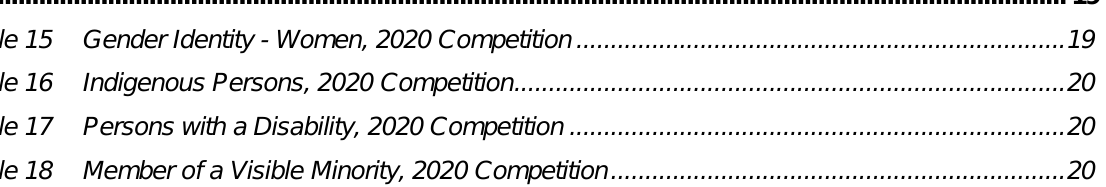
Overall Comparative Statistics, Subatomic Physics Programs Competitions, 2016-20 ....... 19 SECTION 6 - COMPETITION RESULTS DISAGGREGATED BY APPLICANT SELF-IDENTIFICATION